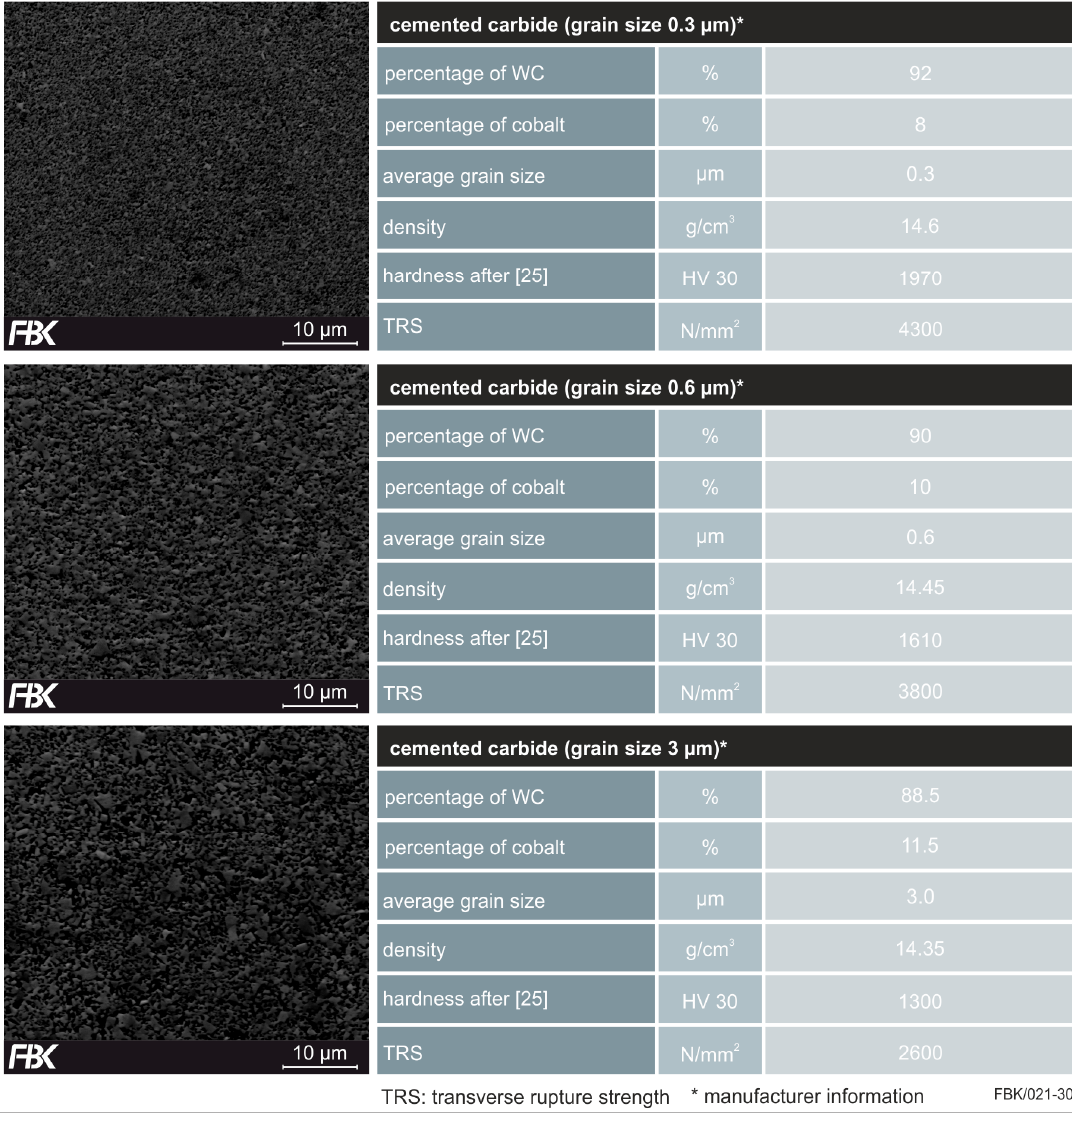
Figure 10. Specifications of cemented carbide for the different grain sizes of ( top ) 0.3 µm, ( middle ) 0.6 µm and ( bottom ) 3 µm